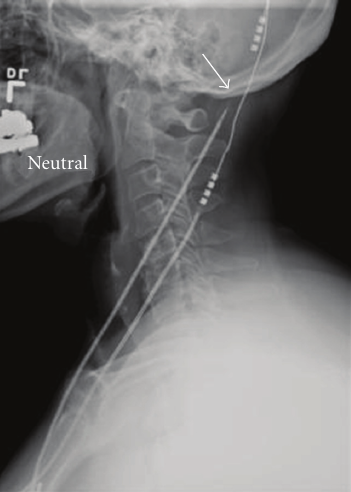
Figure 1: Lateral X-ray showing discontinuity of the right extension lead (arrow). Note that both the right and the left connections are low relative to the skull.